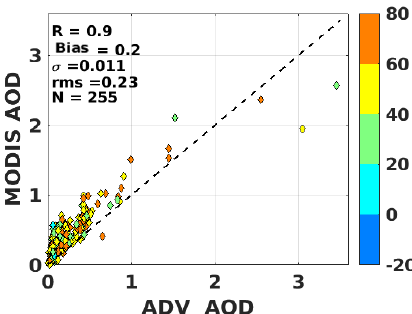
Figure 9. MODIS/Terra C6.1 DTDB merged AOD vs. ATSR ADV v2.31 AOD, for collocated ATSR–MODIS/Terra–AERONET data, as described in Sect. 4.1. The colors (scale at the right) indicate the difference between the MODIS/Terra and ATSR overpass times in